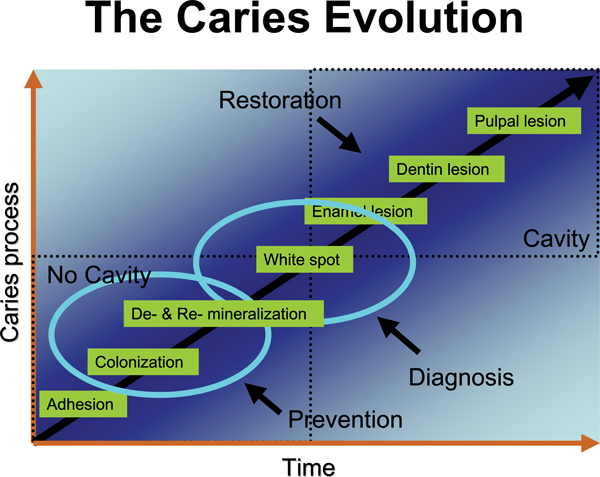
The Caries Evolution.